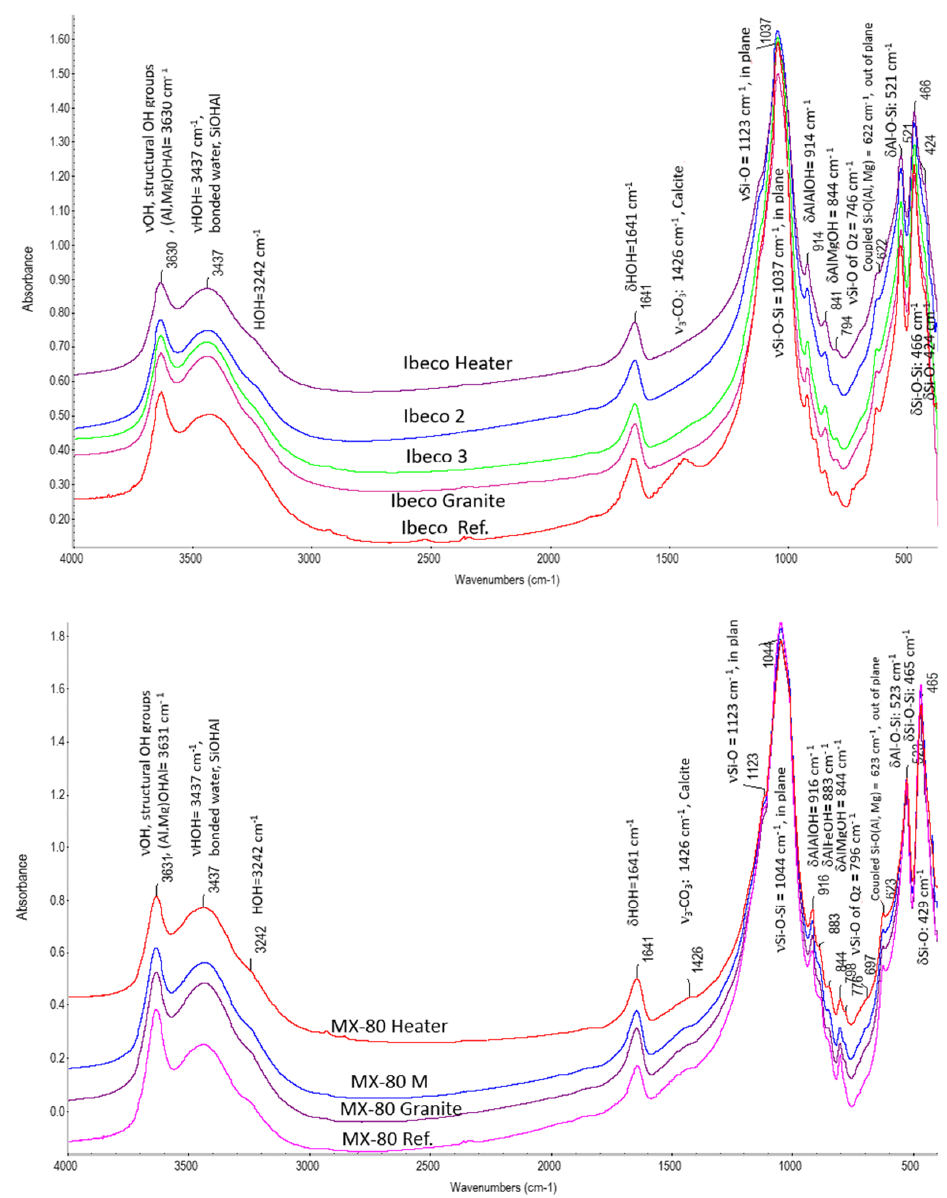
Figure 8. FTIR spectra from samples taken from the ABM5 experiment: Ibeco block 11 and MX-80 Block 1.